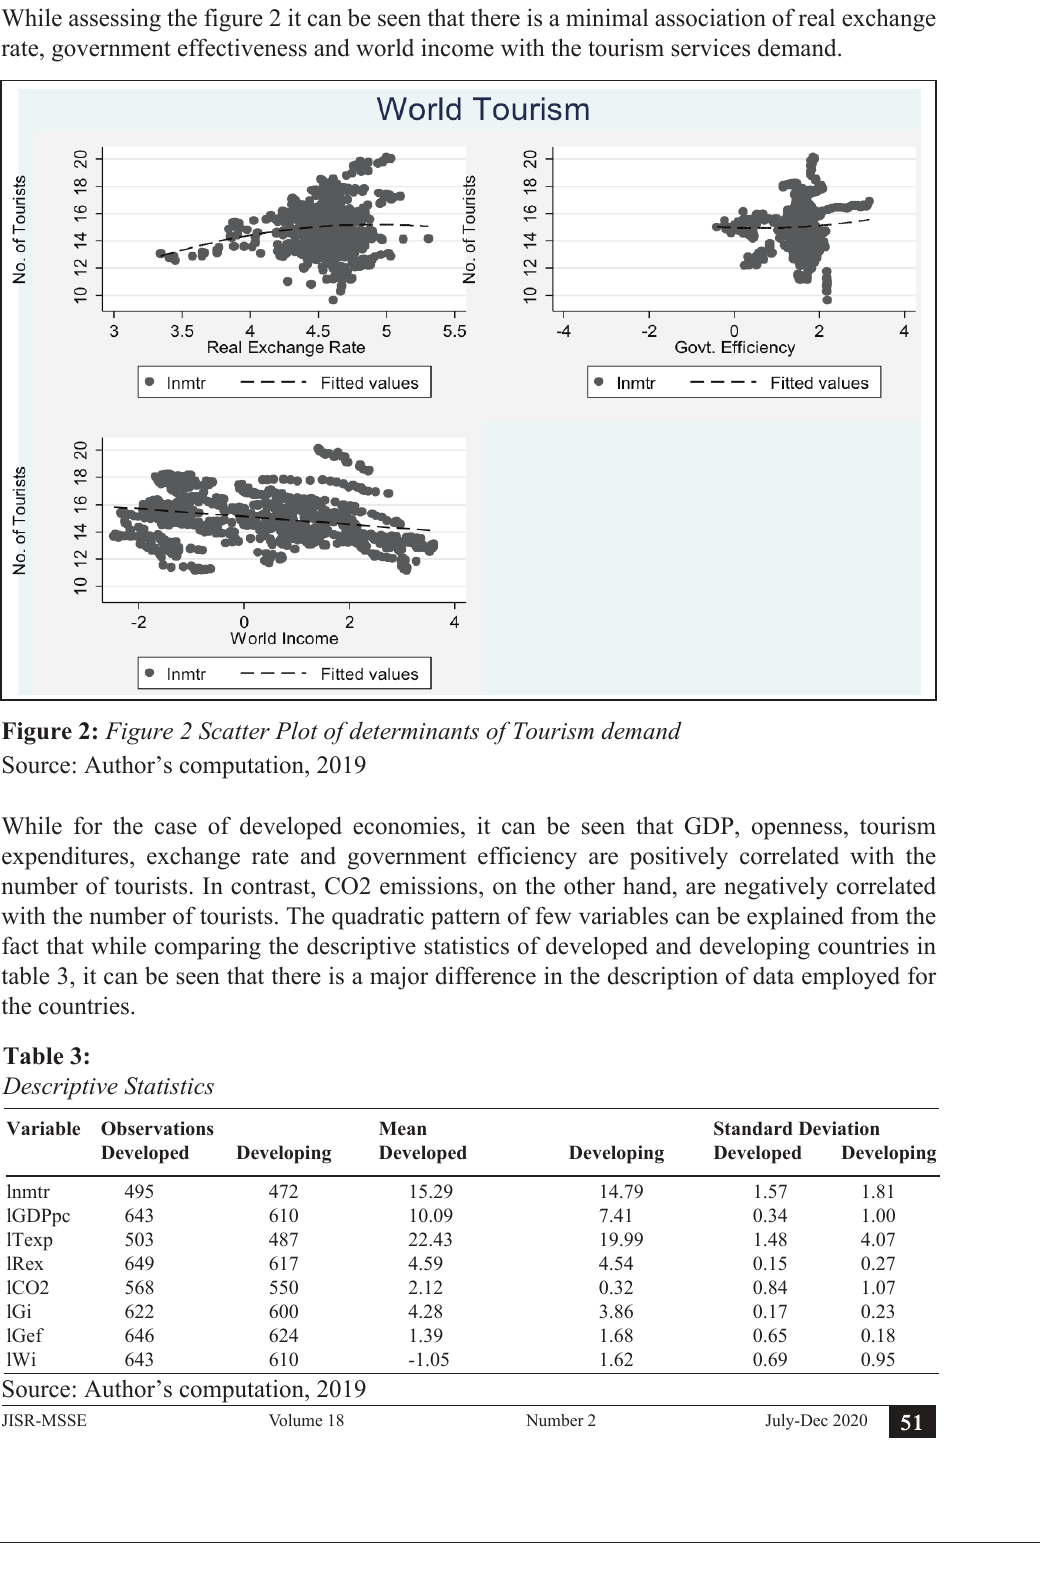
While assessing the figure 2 it can be seen that there is a minimal association of real exchange rate, government effectiveness and world income with the tourism services demand.